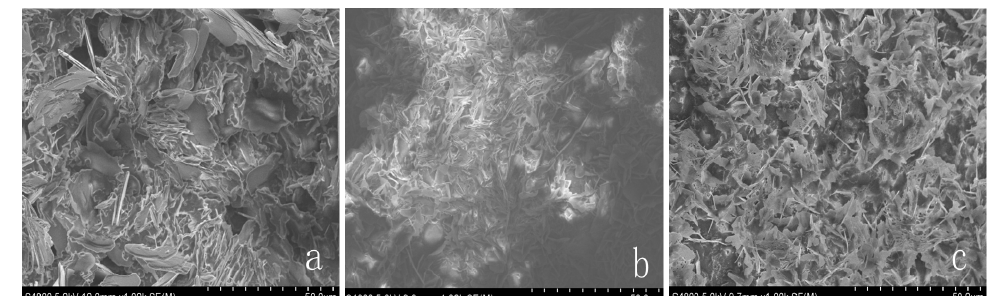
Figure 5. ( a ) SEM images of FS TD-CA PCM (500×); ( b ) SEM images of FS TD-LA (500×); ( c ) SEM images of FS TD-MA PCM